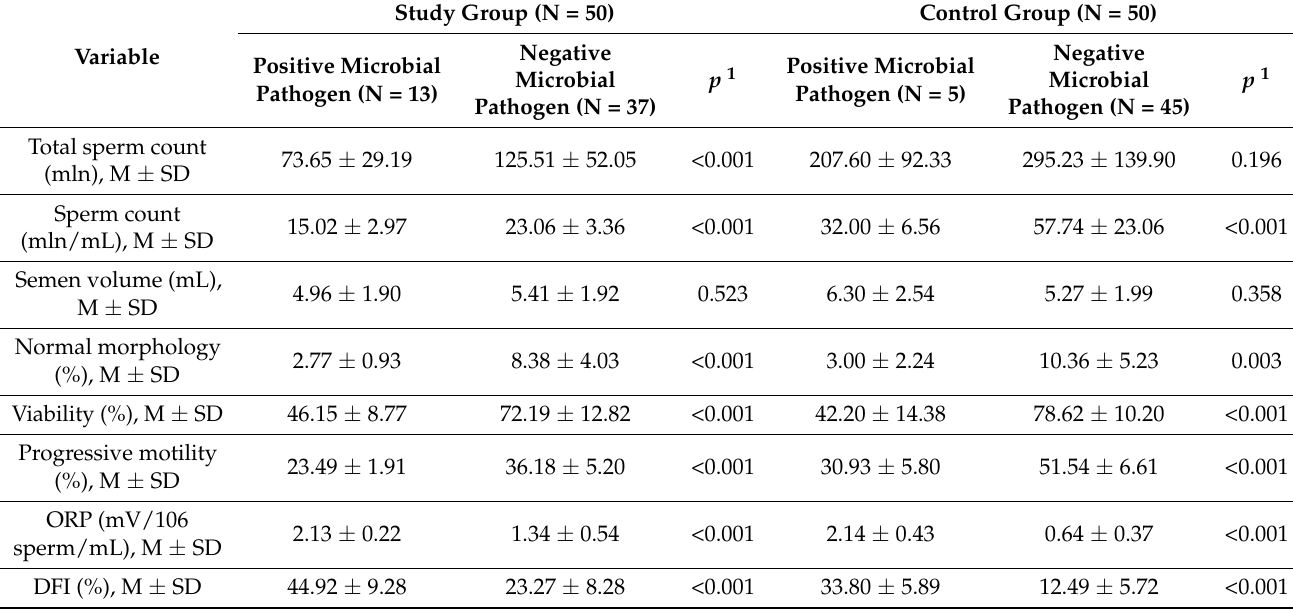
Table 5. Semen parameters, oxidation-reduction potential (ORP) and DNA fragmentation index (DFI) versus micro- bial